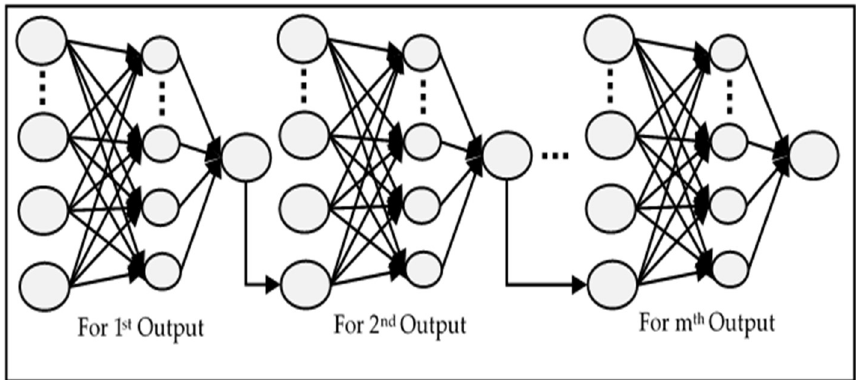
Figure 5. Structure of a typical